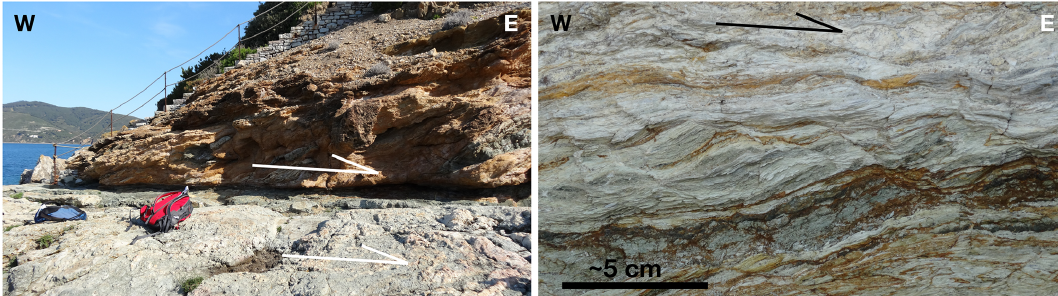
Figure 9. Left: overview of the detachment fault. Right: detail of the shear bands indicating top-to-the-east kinematics.